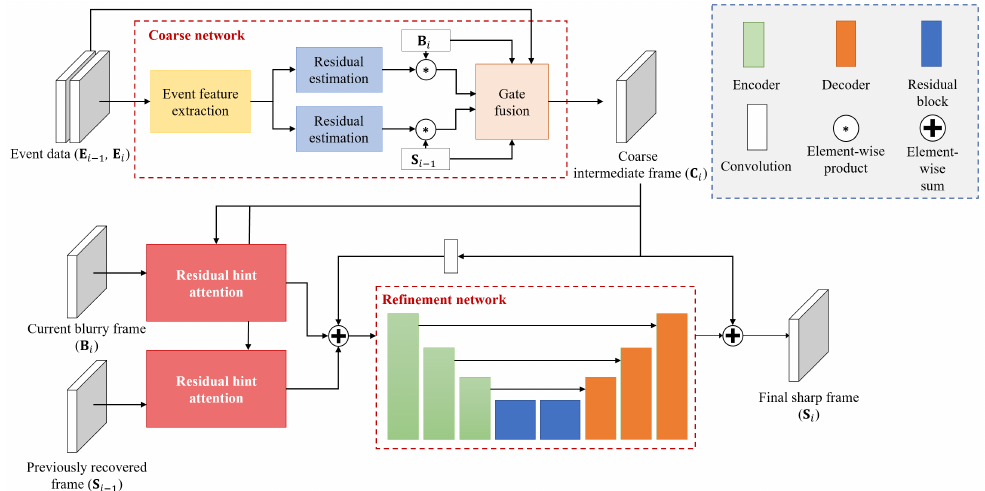
Figure 2. Overall structure of the proposed multi-stage event-based video deblurring network with residual hint attention